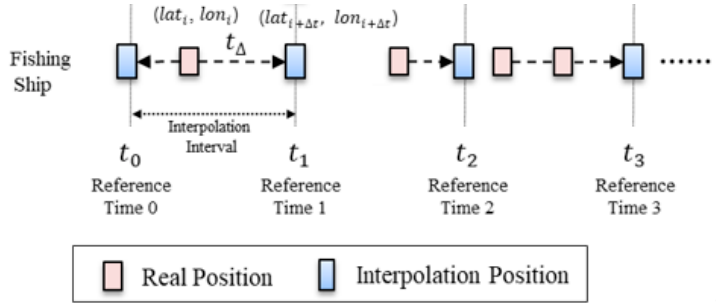
Figure 2. Real positions and sampled positions on the interpolated path.